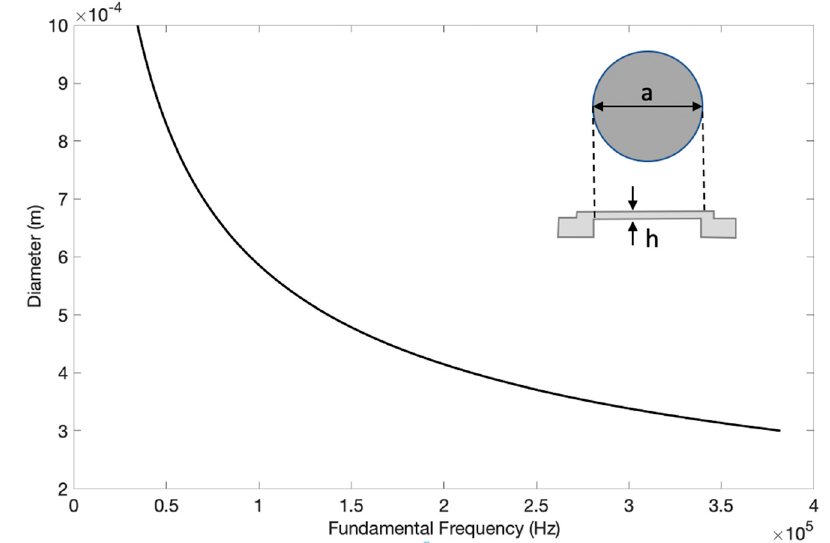
Figure 6. The relationship between fundamental frequency and diameter of a 10 µ m silicon microstructure with simply supported boundary condition.